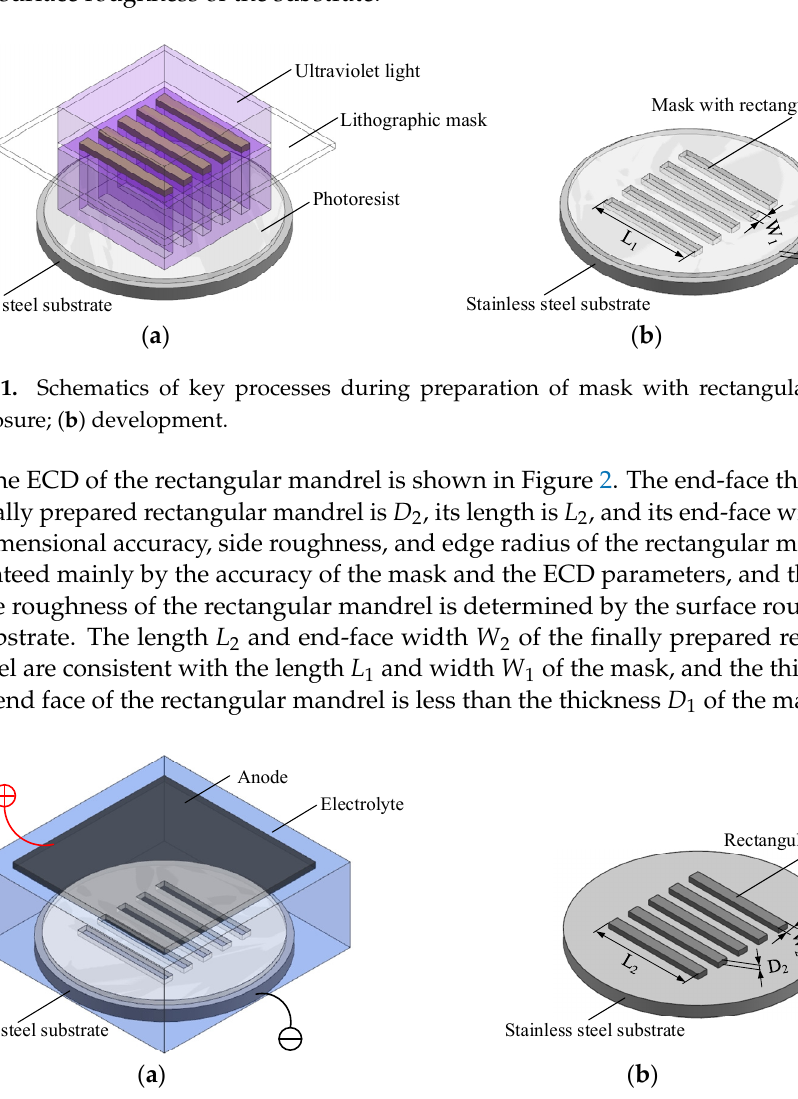
Figure 2. Schematics of manufacturing rectangular mandrel by ECD: ( a ) process; ( b ) result.